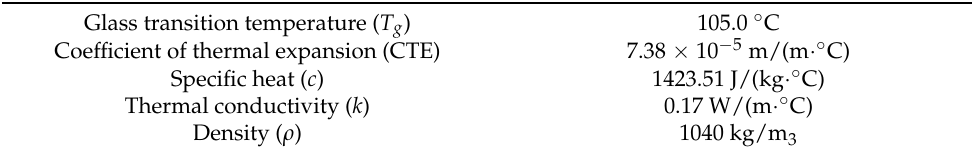
Figure 5. Schematic representation of thermal and flow boundary conditions applied to the model (not to scale).